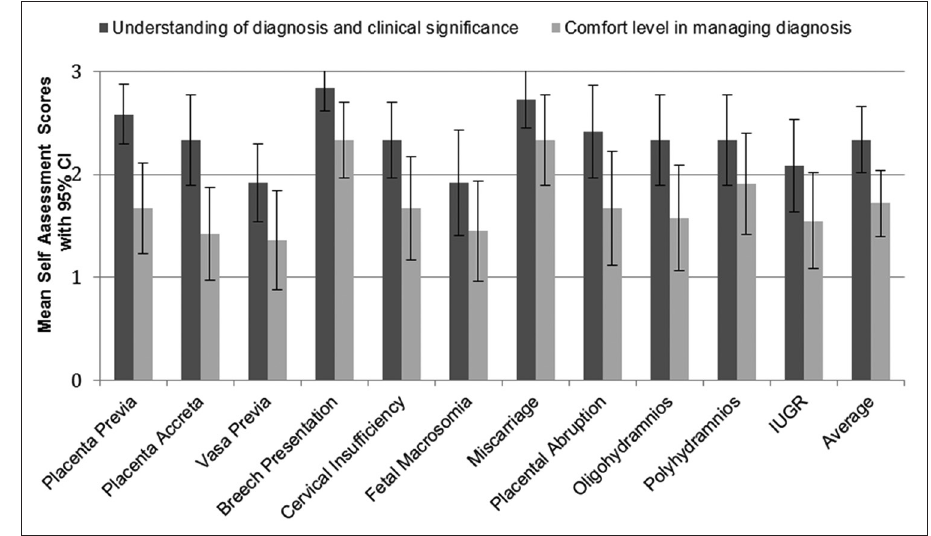
Figure 2 : Midwives’ Self-Assessment. Response averages of 12 midwives using rating scale of 1 to